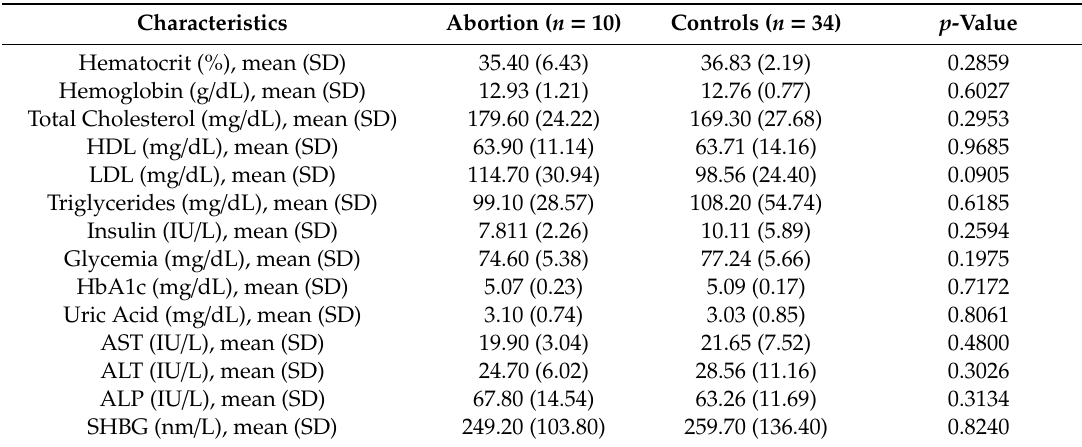
Table 2. Biochemical characteristics of the study